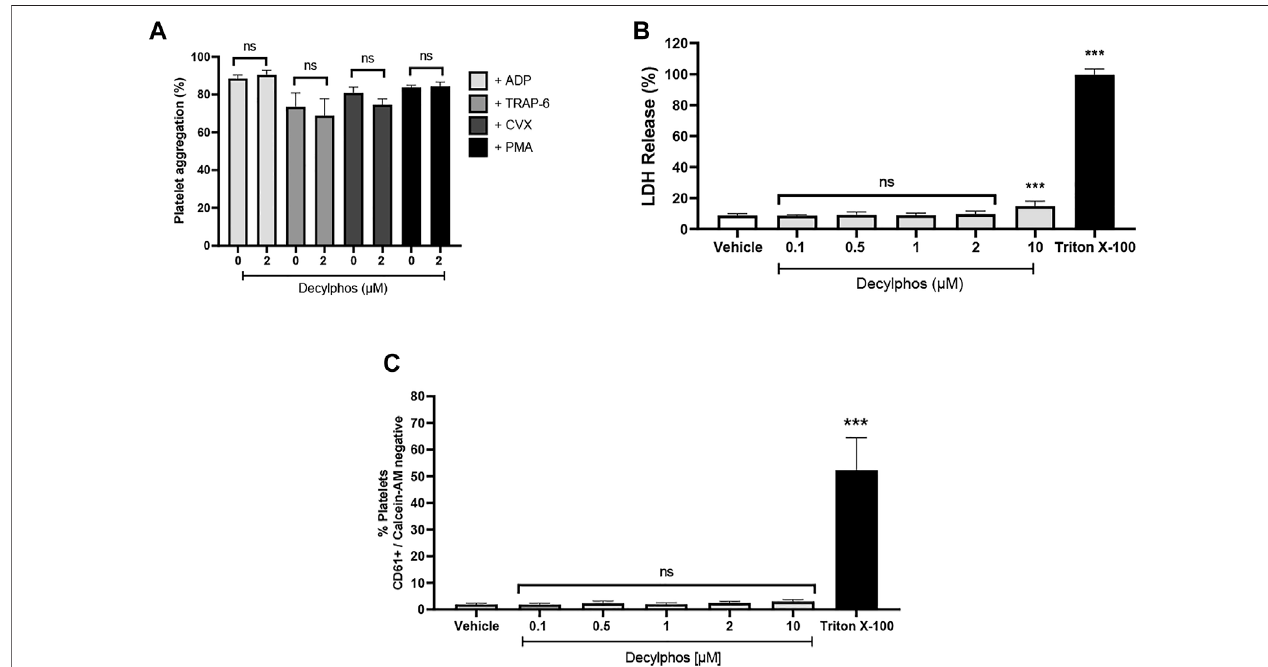
FIGURE 5 | Effect of decylphos on platelet aggregation, cytotoxicity, and cell viability. (A) Platelet aggregation (B) , LDH release from platelets (C) , and platelet viability by Calcein-AM. The results were expressed as mean ± SEM. Vehicle: DMSO 0.4%. The statistical analysis was performed using a one-way analysis of variance (ANOVA) and the Bonferroni post hoc test. ppp p < 0.001 vs.